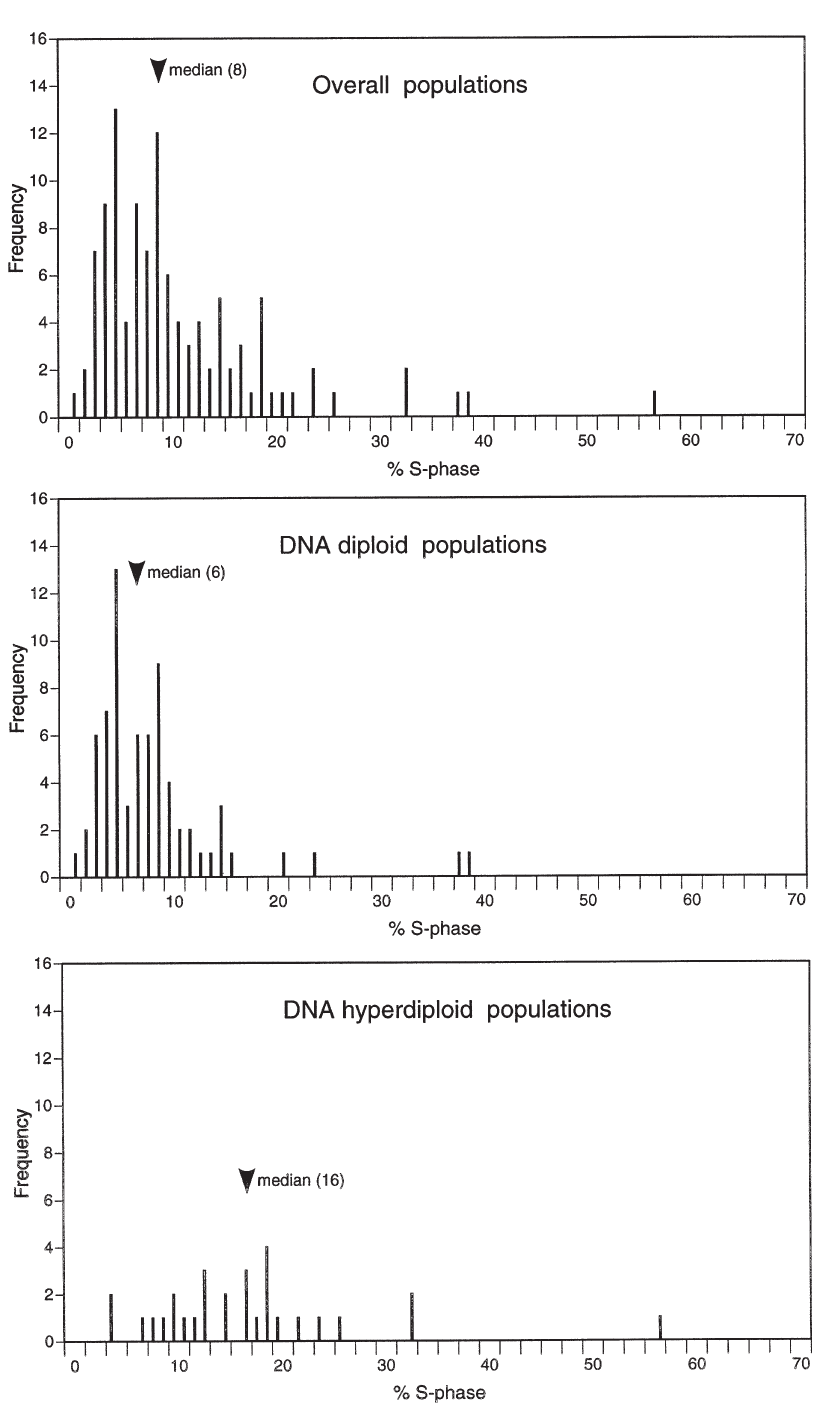
Fig. 1. Frequency distributions of %S-phase values for 110 samples of breast tumours and for the tumours divided according to the DNA